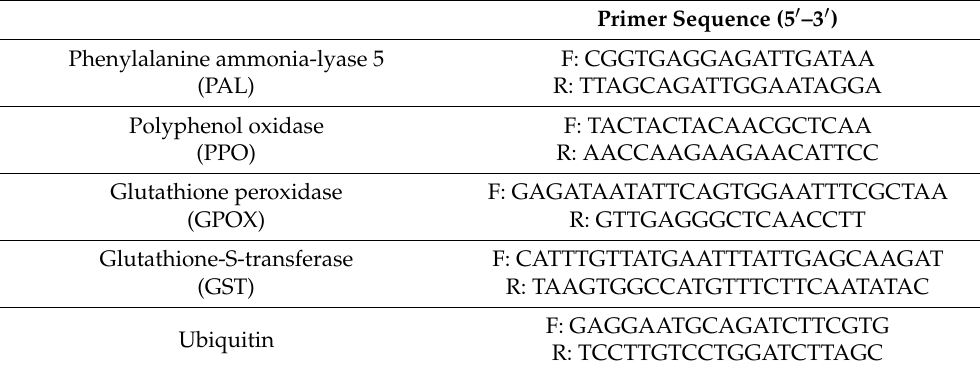
Table 1. Forward and reverse primers sequence for PAL, PPO, GPOX, GST, and Ubiquitin genes.